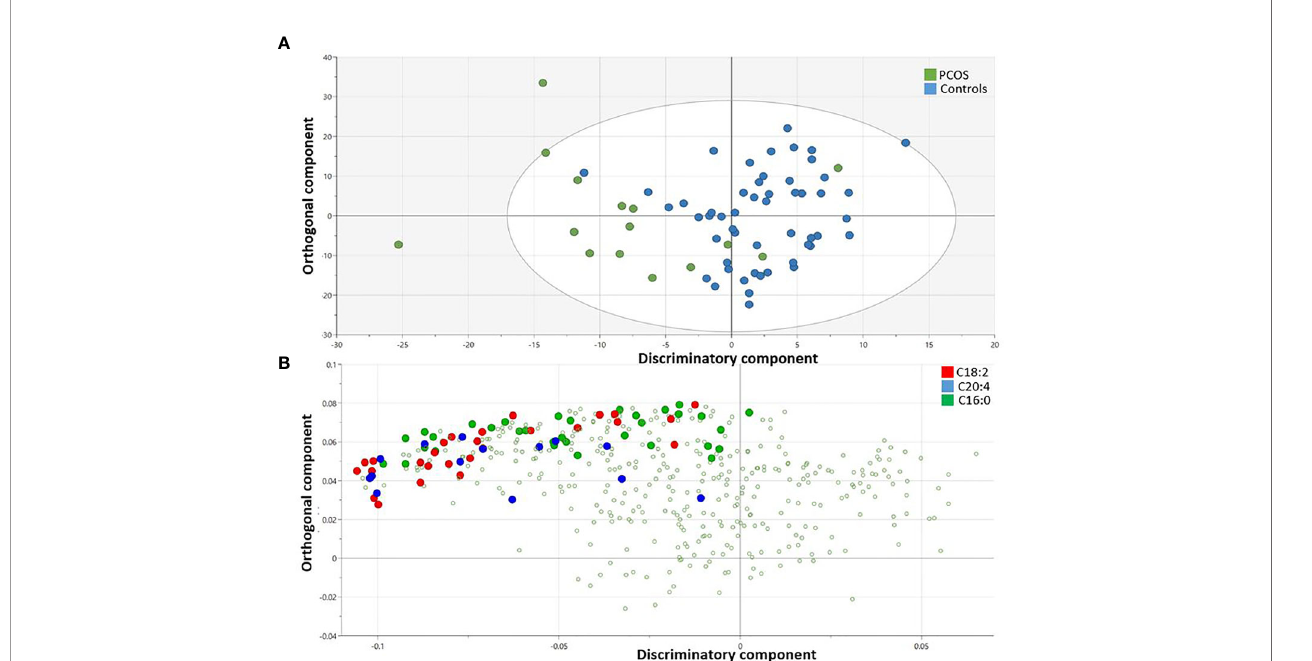
FIGURE 2 | OPLS-DA model comparing metabolites from controls and PCOS mothers. Score plot shows one dimensional separation on the x-axis between controls and PCOS mothers (A) and the corresponding loading plot indicates triacylglycerols containing enriched fatty acids (C20:4, C18:2 and C16:0) that are responsible for the group separation (B)